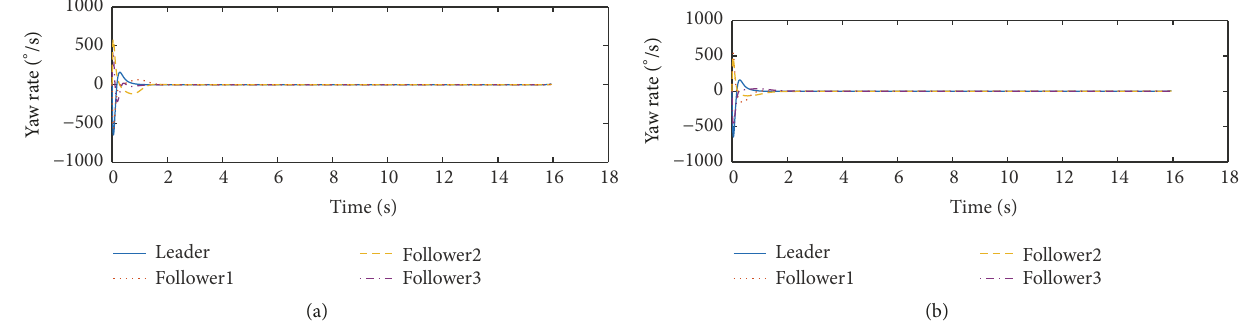
Figure 11: Yaw rate curve in the global and local communication topologies: (a) yaw rate curve in the global communication topology; (b) yaw rate curve in the local communication topology.